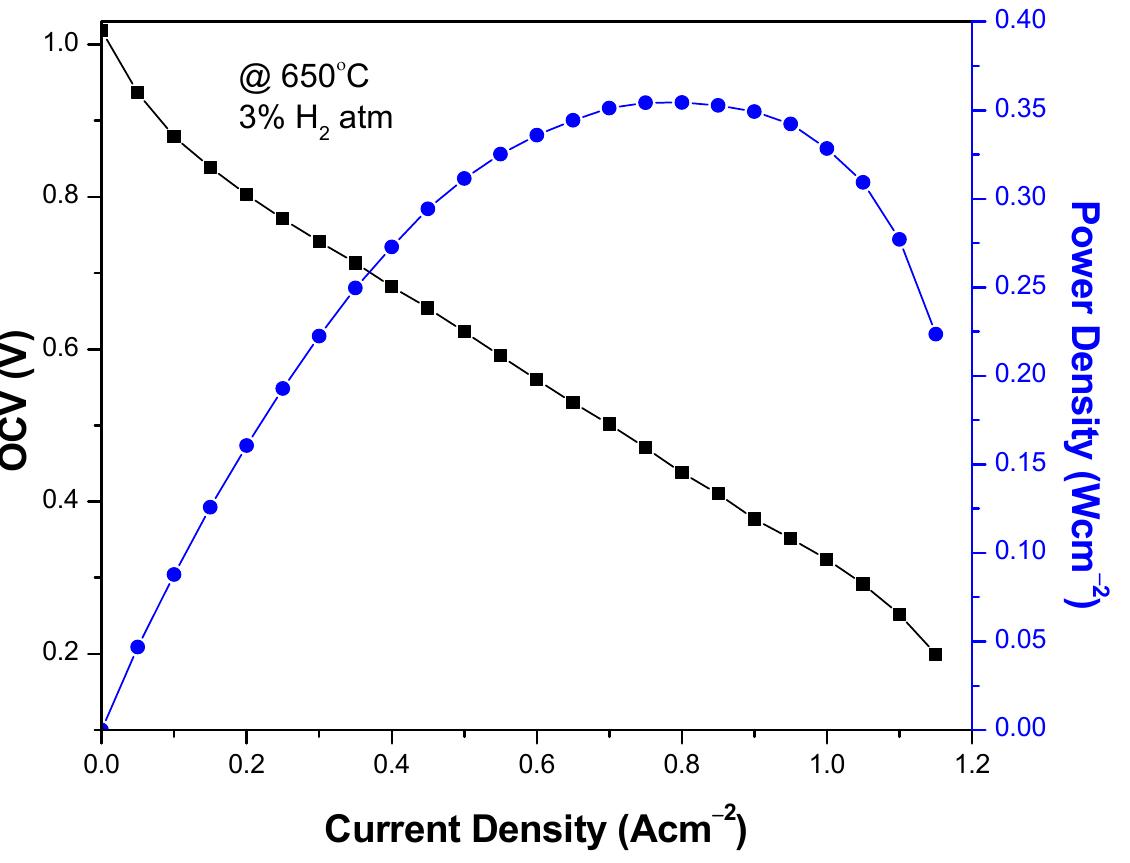
Figure 5. Electrochemical performance of cell with BaCe 0.2 Zr 0.6 Y 0.2 O 3 - δ electrolyte sintered at 1100 ˚C .